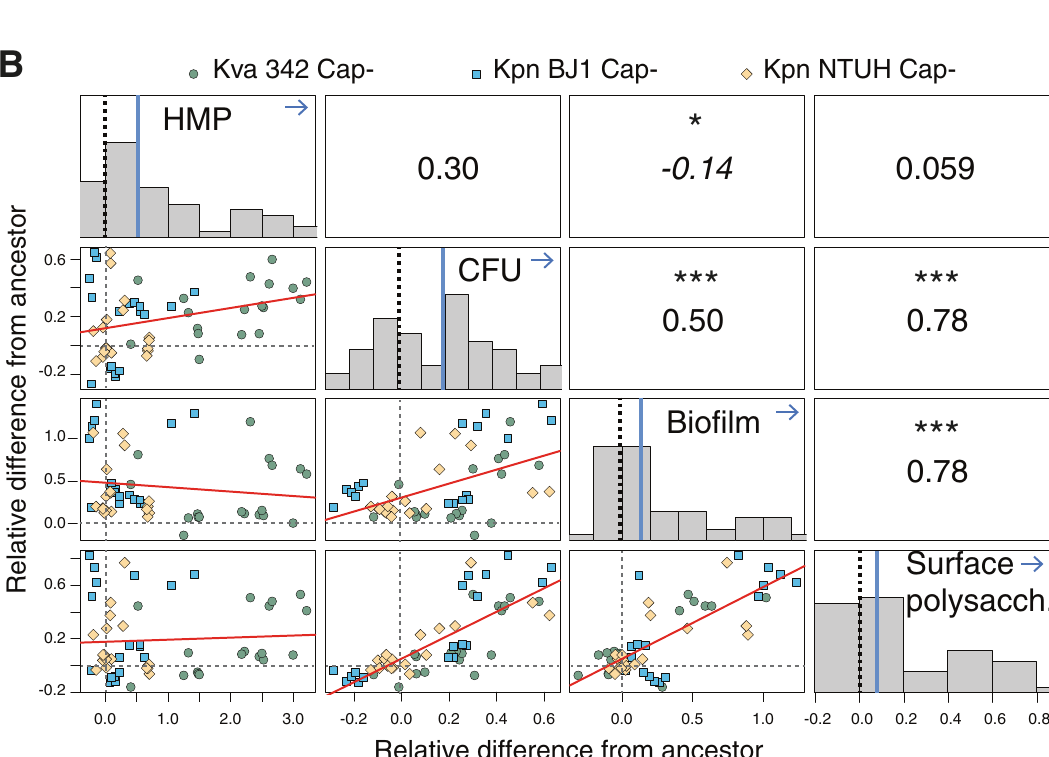
stable coexistence between capsulated and non-capsulated clones (Fig. S3,example: Population 6 ofKpn BJ1 or Population 5 of Kva 342 in ASM, and most populations of Kpn NTUH in AUM), but in most cases, the frequency of non-capsulated alleles changed rapidly. This resulted in the elimination of the non-capsulated clones from the population